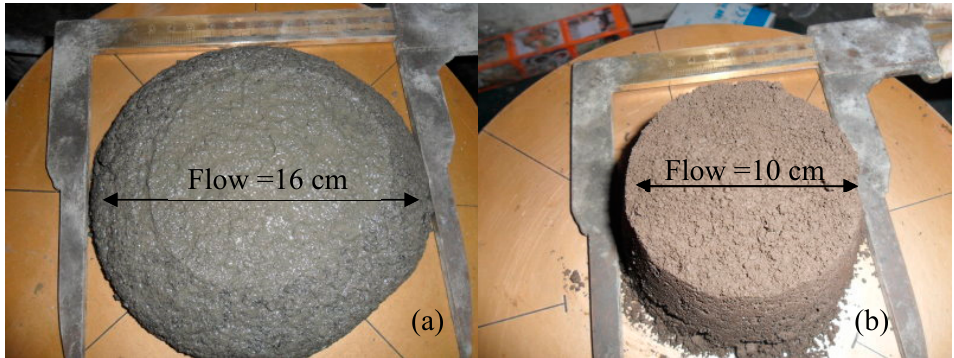
Figure 8. Mortar specimens used in flow tests: ( a ) ordinary Portland mortar, OPM; ( b ) specimen with 70% of 10,000 cm 2 /g BOFS.